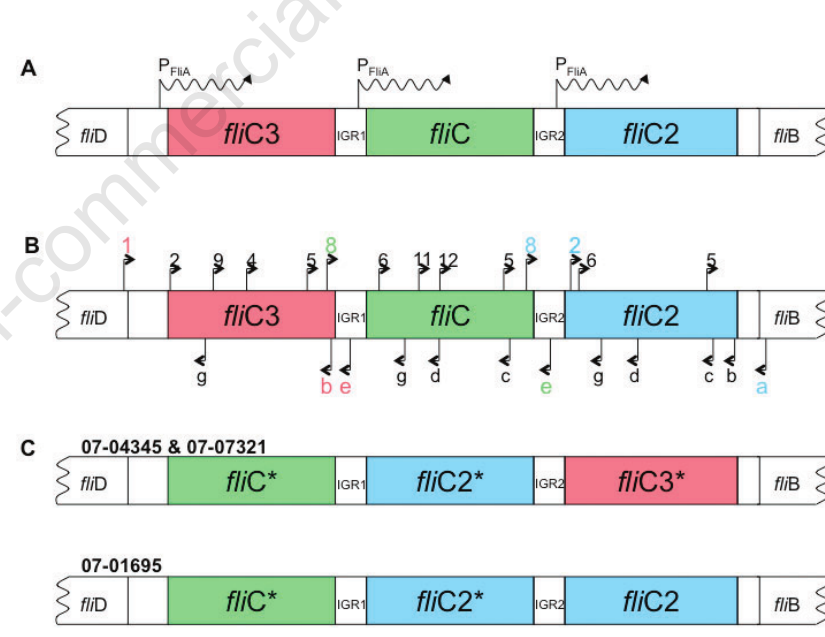
Figure 1. Schematic view of the organisation of the genome segment harbouring the three flagellin genes fliC3, fliC and fliC2 in Y. enterocolitica 8081 (biotype 1B) flanked by fliD and fliB (A). IGR1 and IGR2 designate the two intergenic regions between the flagellin genes. Transcription (Promoter P ) of all three flagellin genes is under control of FliA, FliA the flagella-specific sigma factor σ F, also designated σ 28 . (B) Primers used for amplifica- tion of genomic fragments are colored; binding sites of additional sequencing primers are indicated in black. Labelling “a” to “g” refers to primers fli_a to fli_g; “1” to “12” refers to primers fli_1 to fli_12 (see Table 2). (C) Atypical arrangement of the three flagellin genes in Y. enterocolitica biotype 1A strains 07-01695, 07-04345 and 07-07321 (compare to Table 1). Colour code and gene designation refer to homology to Y. enterocolitica 8081 flagellin genes. Asterisks indicate relocated flagellin genes compared to the order of fla- gellin genes found in Y. enterocolitica 8081 (see